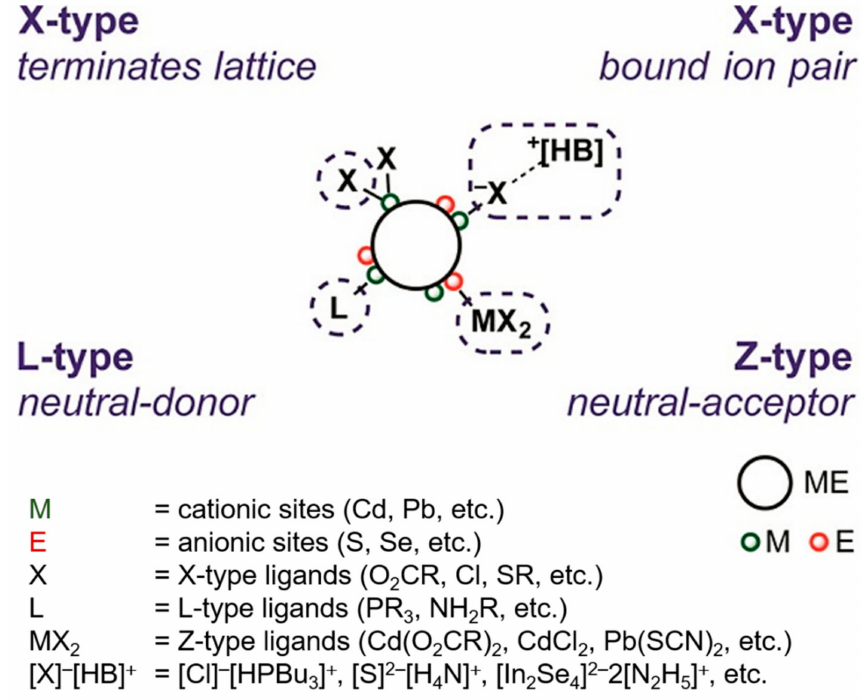
Figure 1. Classification of the bonding nature of ligands. Reprinted with permission from